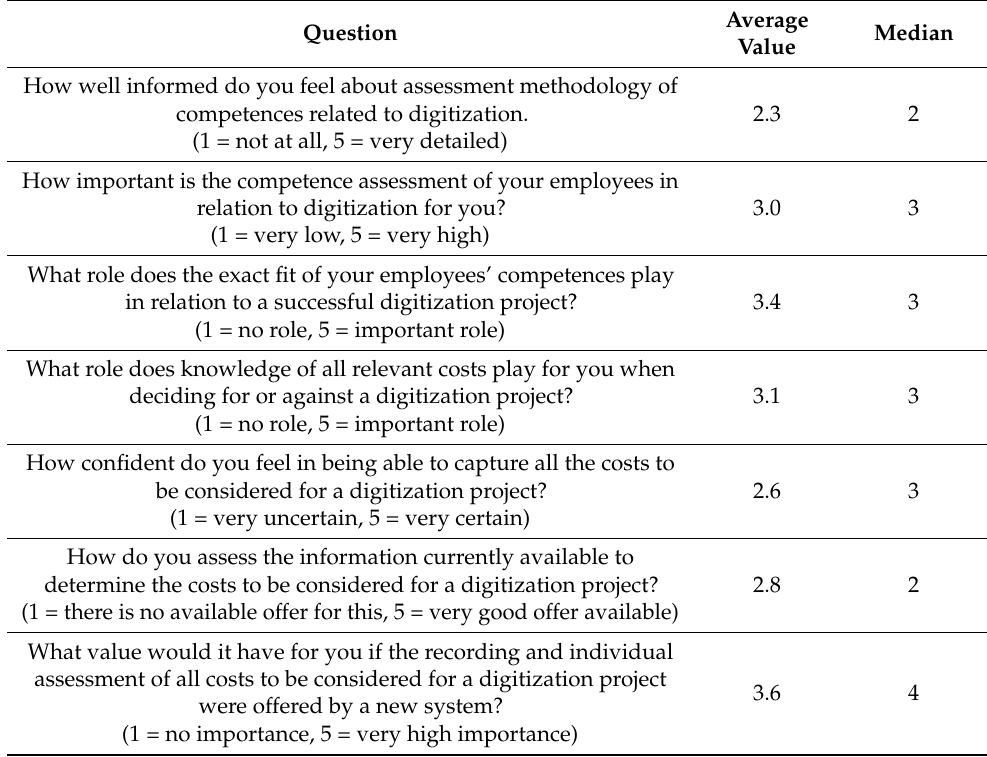
Table 7. Participant survey intensive workshop ( n =